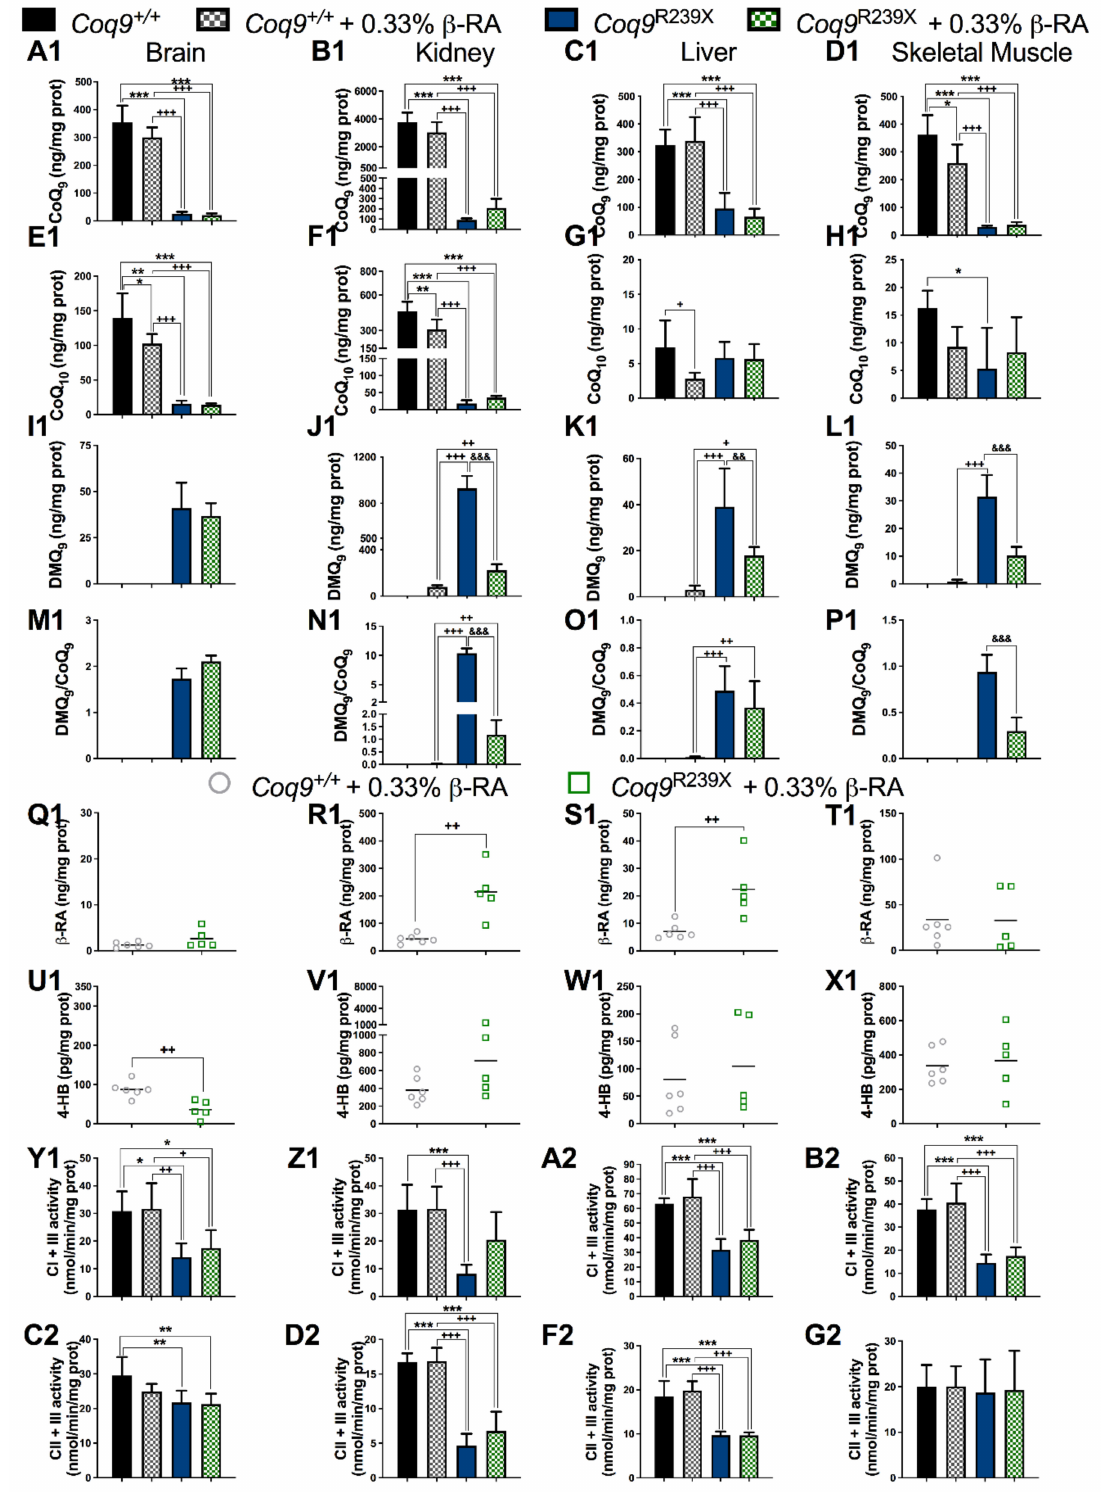
Figure 3. CoQ metabolism and mitochondrial function in the tissues from the Coq9 +/+ mice, Coq9 +/+ mice given supplemen- tation with 0.33% β -RA, Coq9 R239X mice, and Coq9 R239X mice given supplementation with 0.33% β -RA. ( A1 – D1 ) Levels of CoQ 9 in the brain ( A1 ), kidneys ( B1 ), liver ( C1 ), and hind legs skeletal muscle ( D1 ) from the Coq9 +/+ mice, Coq9 +/+ mice given the 0.33% β -RA treatment, Coq9 R239X mice, and Coq9 R239X mice given the 0.33% β -RA treatment. ( E1 – H1 ) Levels of CoQ 10 in the brain ( E1 ), kidneys ( F1 ), liver ( G1 ) and hind legs skeletal muscle ( H1 ) from the Coq9 +/+ mice, Coq9 +/+ mice given the 0.33% β -RA treatment, Coq9 R239X mice, and Coq9 R239X mice given the 0.33% β -RA treatment. ( I1 – L1 ) Levels of DMQ 9 in